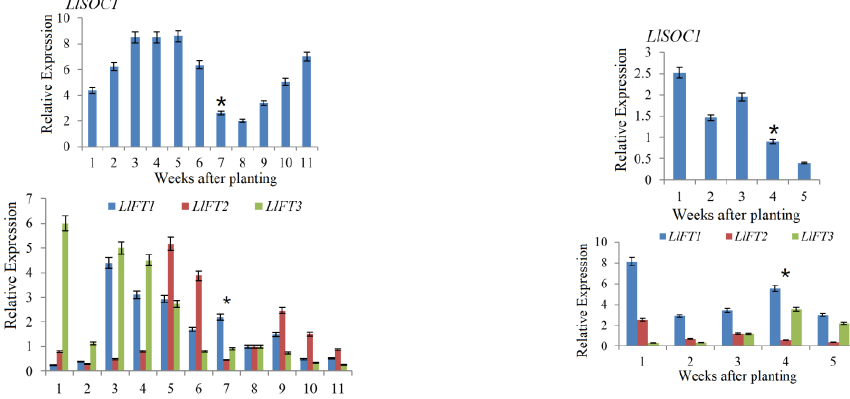
Figure 3. The expression patterns of LlSOC1 , LlFTs in leaves of Lilium longiflorum grown under SD/LD conditions. Notes: These abbreviations are the same as above. SD, short day (light/dark: 8/16 h); LD, long day (light/dark: 16/8 h). * visible buds appeared time after planting.